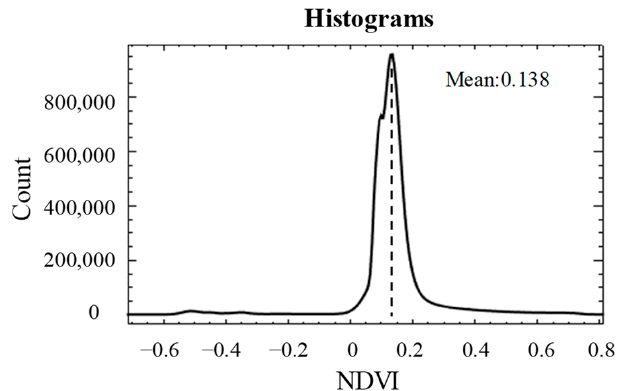
Figure 5. Statistics histogram of NDVI values in the study area.